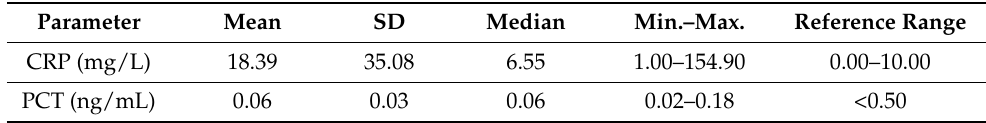
Table 1. The results of inflammatory biomarkers of COVID-19 patients on